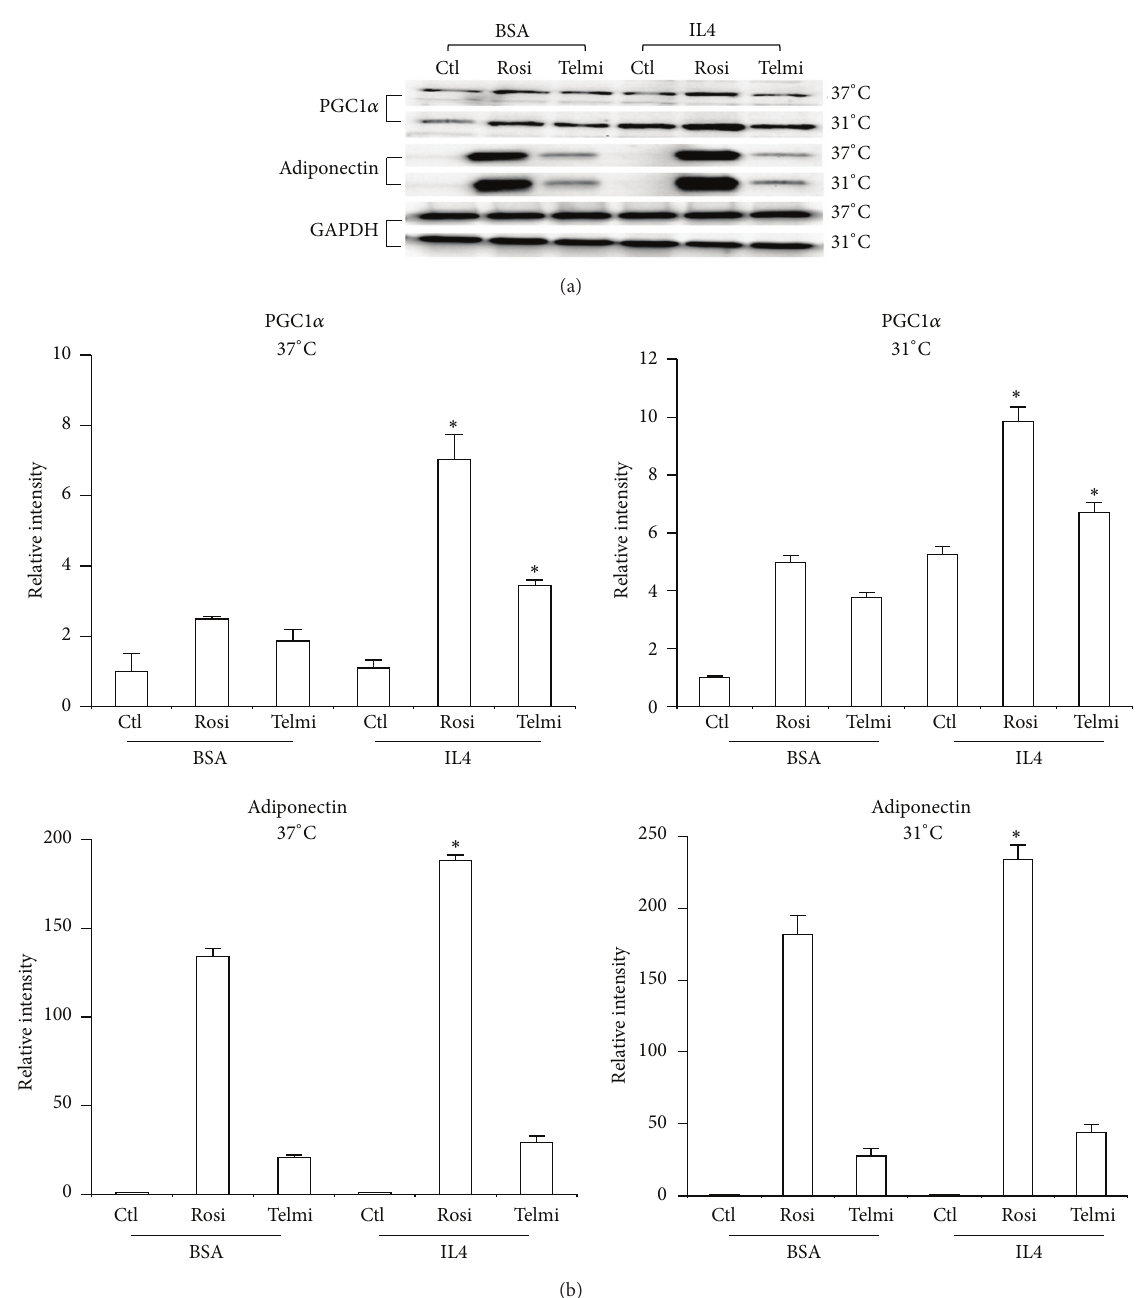
Figure 4: Effect of IL4 in the levels of adipocytokines. (a) The differentiated adipocytes were obtained and treated as describe before; total protein was isolated for detecting expression of adiponectin and PGC-1 𝛼 by western blot. IL4 was added to cells during a period of 4 hours and at the same time cells were exposed to 37 ∘ C or 31 ∘ C. (b) Relative intensity levels were determined by densitometry of bands. Analyses were performed using ANOVA test. Data are expressed as mean ± SD and differences were considered significant with 𝑃 < 0.05 . ∗ The differences between the cells treated with